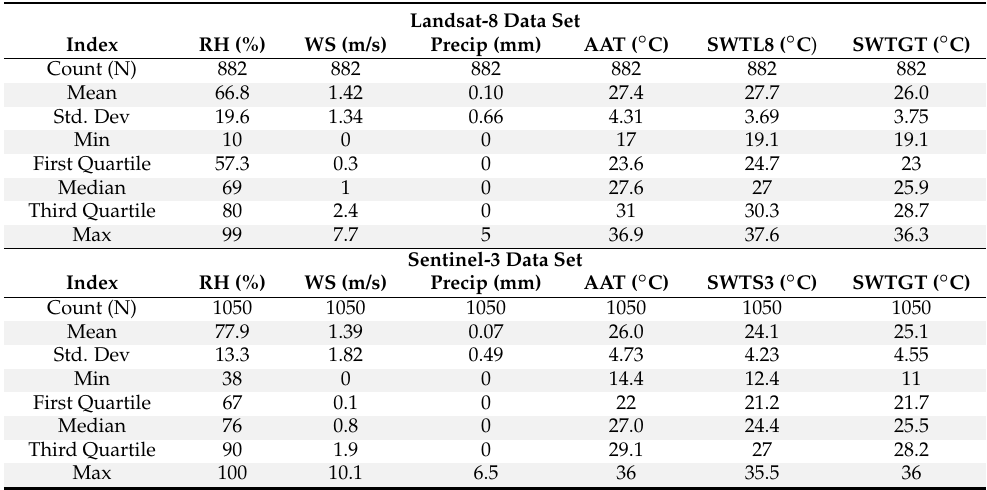
Table 1. Descriptive statistics for all the input variables to the data of the models from